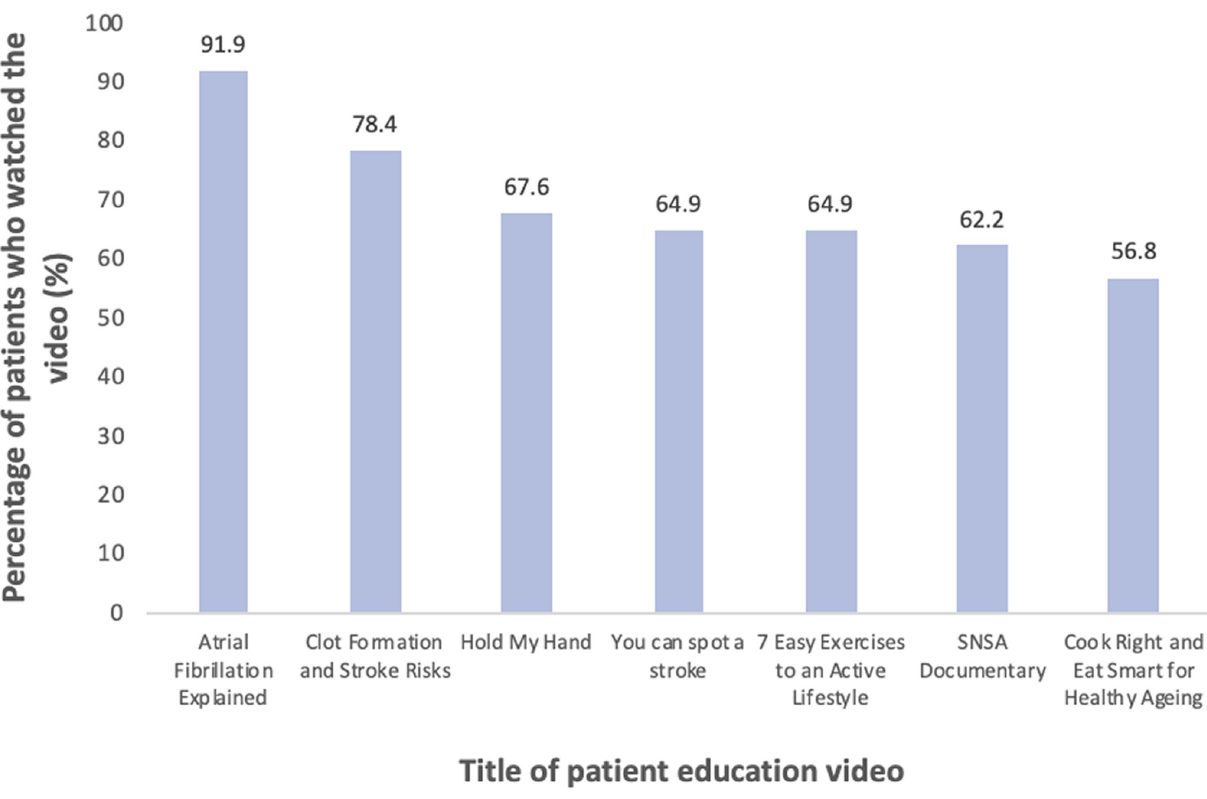
Fig 2. Patient interactions with educational